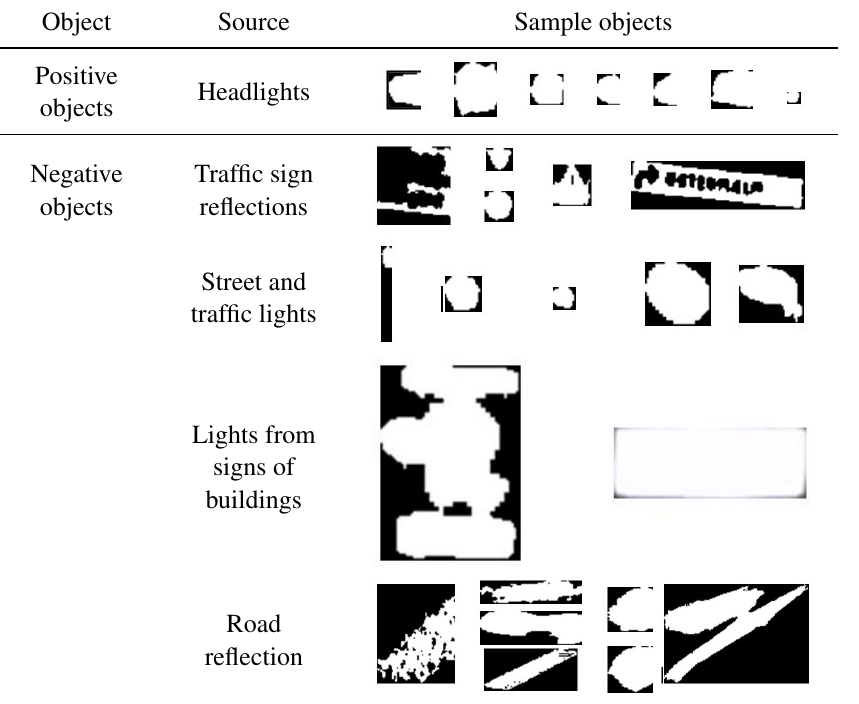
Table 1. Samples of the extracted blobs for training and